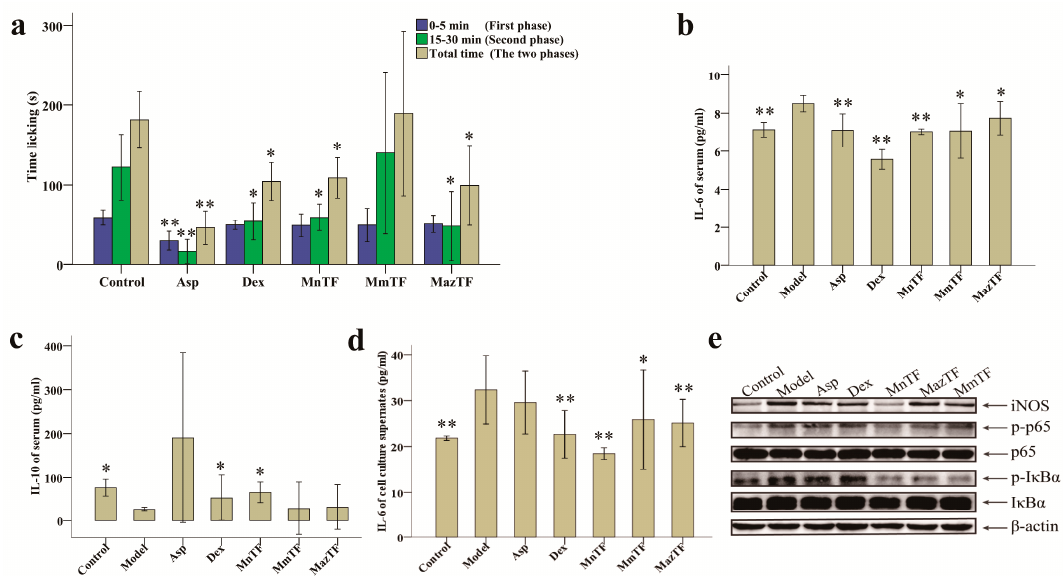
Figure 3. Effects of TFs on pain ( a ); levels of IL-6 ( b ) and IL-10 ( c ) in mice; and levels of IL-6 ( d ) and the expression of pain-related proteins ( e ) in RAW 264.7 cells. Values with asterisks are significantly different (* p < 0.05; ** p < 0.01) from those in the control group in ( a ); or the model group in ( b – d ).